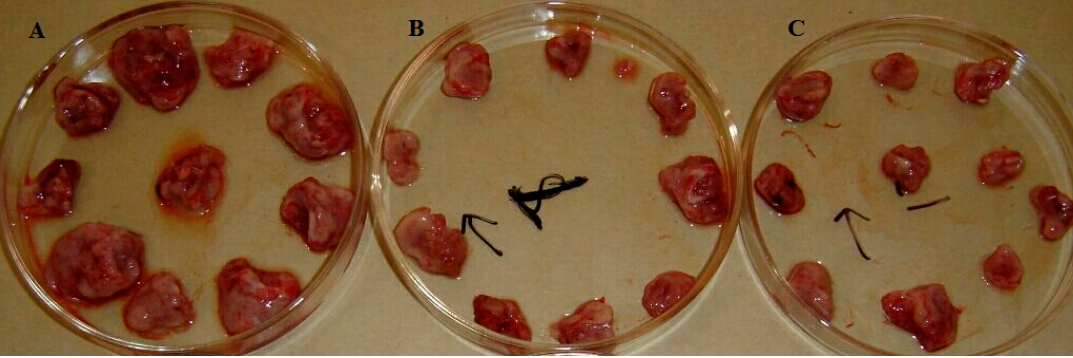
Figure 7. Morphological features of the sarcoma 180 solid tumors that were removed from the Kunming mice in the control ( A ), triterpene acid extract (TAE, 250 mg/kg) ( B ) and 5-FU ( C ) treatment groups (10 mice per group).